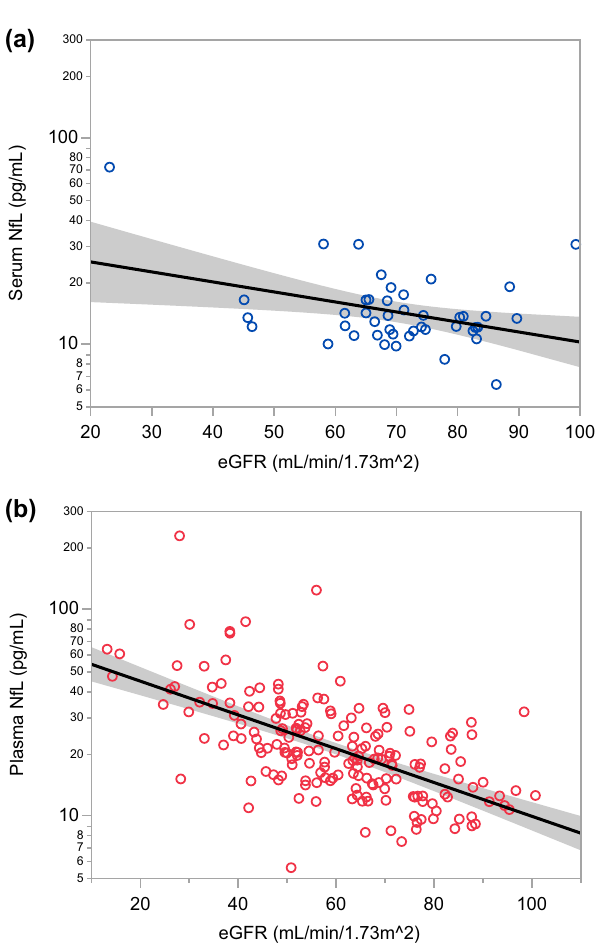
Figure 2. A positive correlation between blood NfL level and eGFR in the HC group ( a ) and the DM group ( b ). NfL: neurofilament light chain, eGFR: estimated glomerular filtration